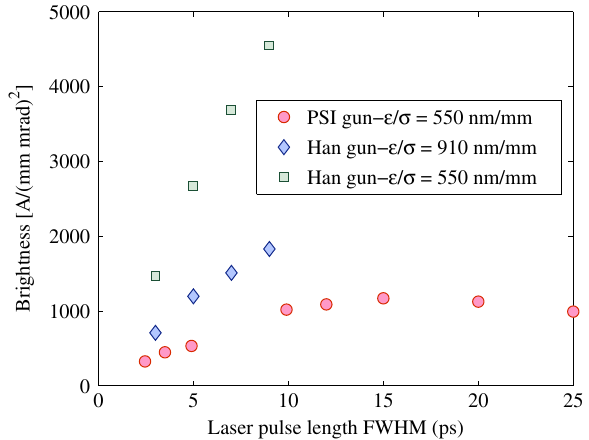
FIG. 11. Optimized brightness as a function of the laser pulse length. The optimization using the PSI and the Han guns are compared. The brightness shown in this plot is defined as the ratio of the average current and the square of the emittance along the central part of the